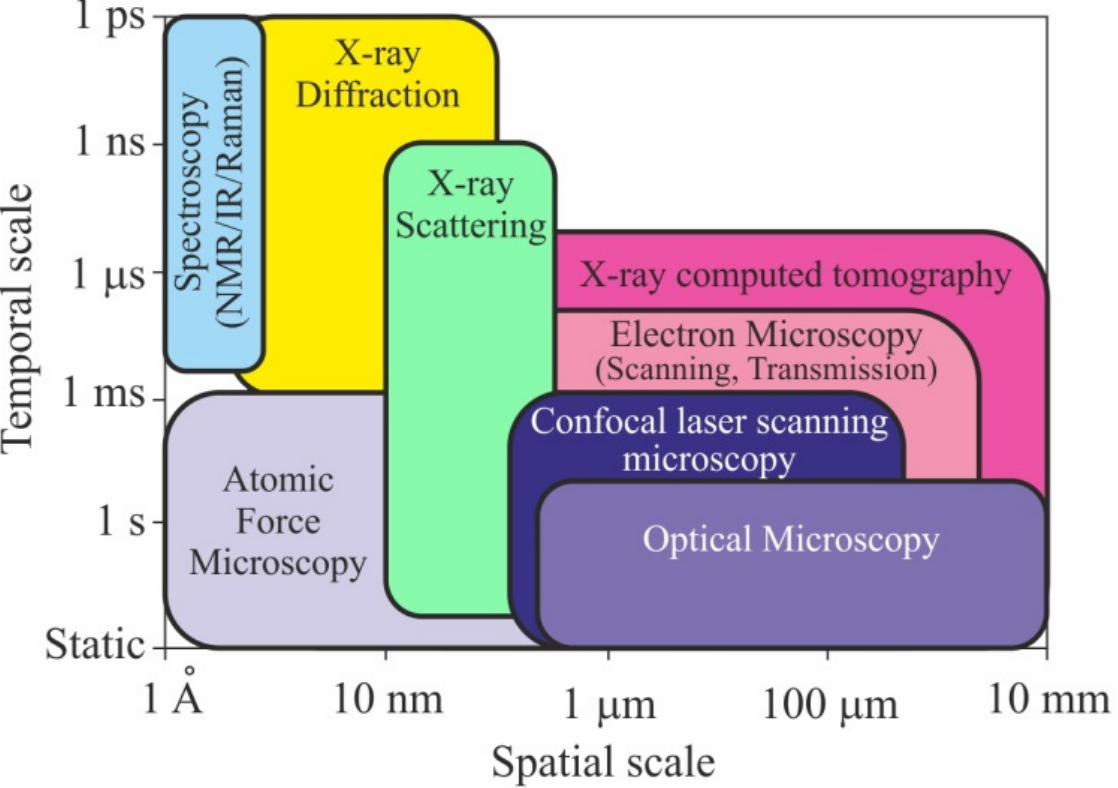
Figure 4. Schematic of the spatiotemporal ranges of the most popular physical methods for studying wood structures. Adapted with permission from Ref. [32]. Copyright 2021, Wiley-VCH